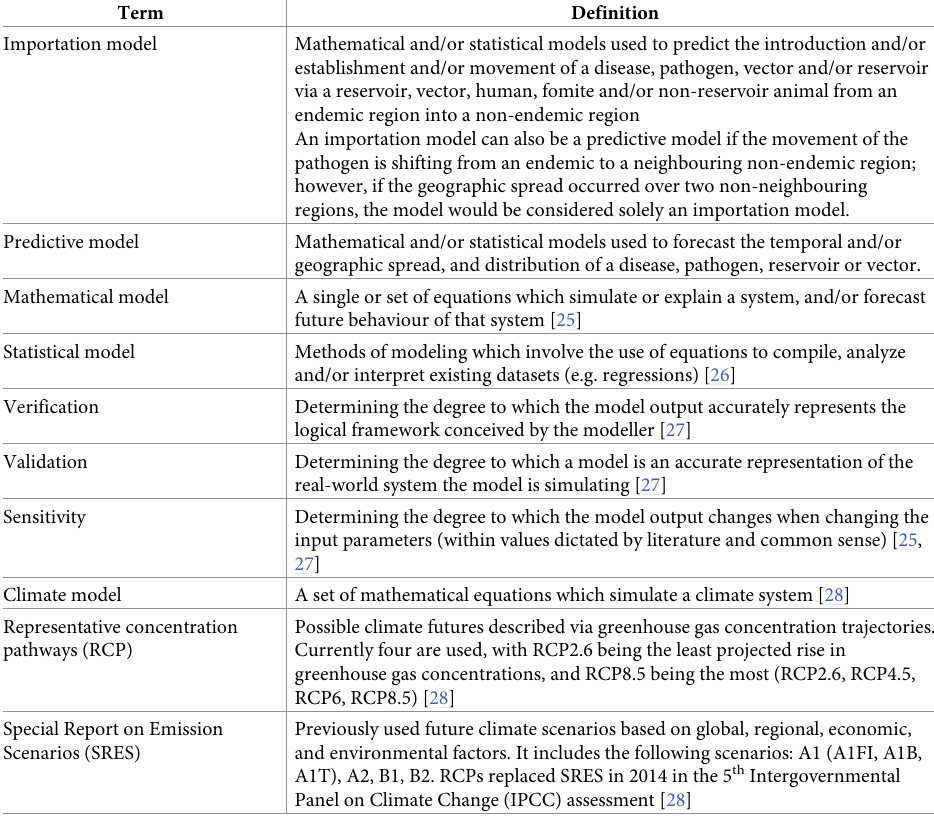
Table 1. Key terms and definitions used throughout the scoping